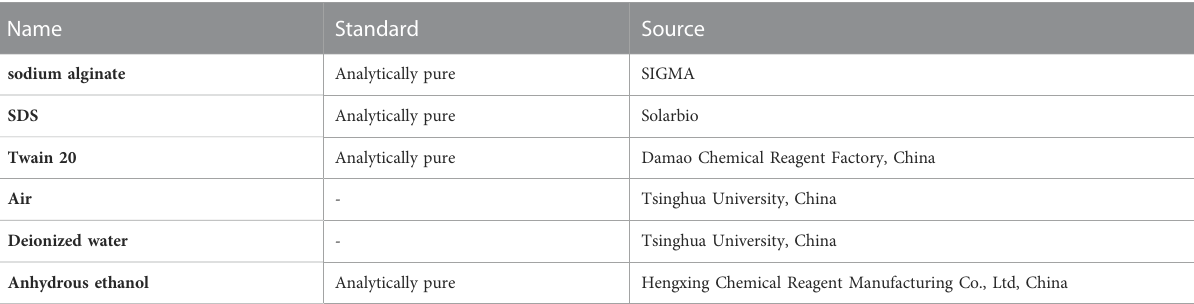
TABLE 1 Experimental material.